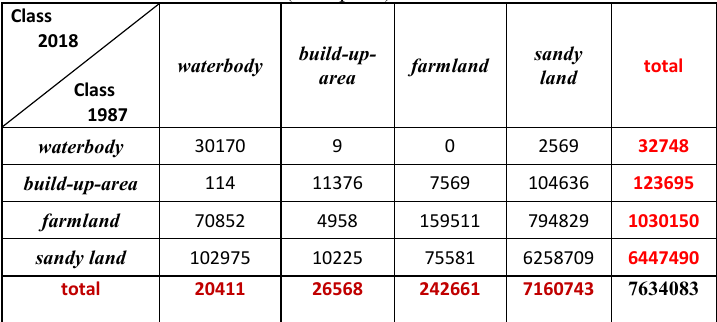
The conversion matrix of land use land cover change from 1987 to 2018 (unit: pixel)